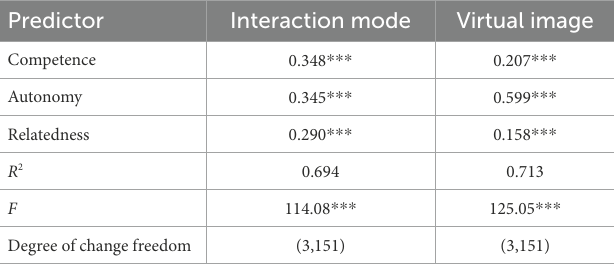
TABLE 8 Multiple linear regression: predicting the automation trust.